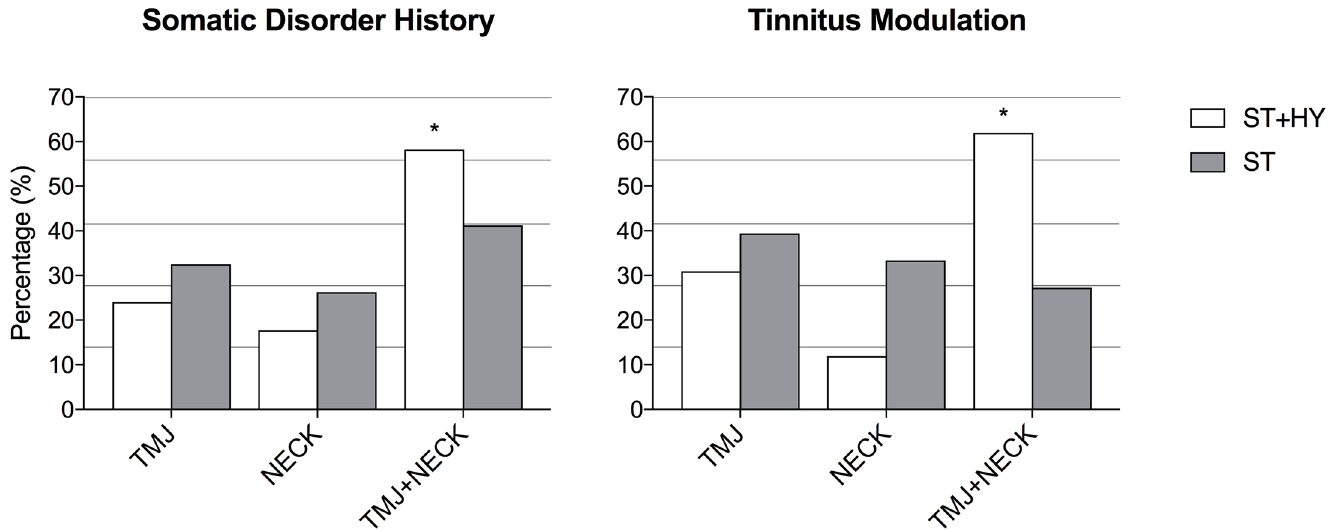
Fig 3. Comparison of somatic disorder history and tinnitus modulation. (A) Percentagesof somatic tinnitus patients with (ST+HY) and without (ST) hyperacusis with temporomandibularjoint (TMJ), headand neck (NECK) and TMJ+NECK problemsamong those with a history of somatic disorders. (B) Percentages of tinnitus modulation followingTMJ, NECK and TMJ+NECK maneuvers among ST+HY vs. ST patients. TMJ+NECK history (p = 0.05) and modulation (p < 0.001)were significantly more common in ST+HY than in ST patients.